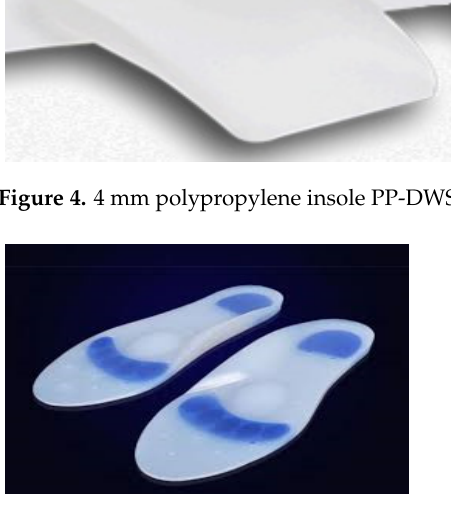
Figure 5. Silicone Comfort Insole.